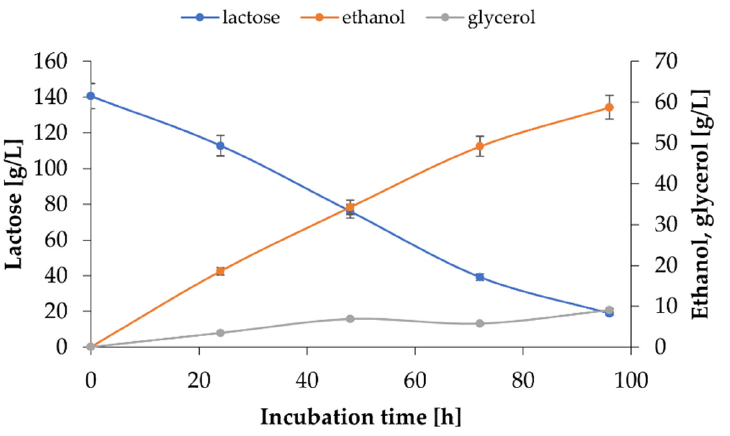
Figure 7. Changes in lactose, ethanol, and glycerol concentration during 96 h culture of K. marxianus WUT240 in WP200 medium at 30 °C in a 4.8-L bioreactor.